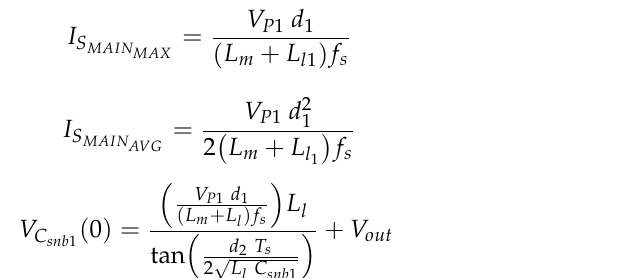
/3 < 𝑡 ≤ 2𝑇 (cid:3046)